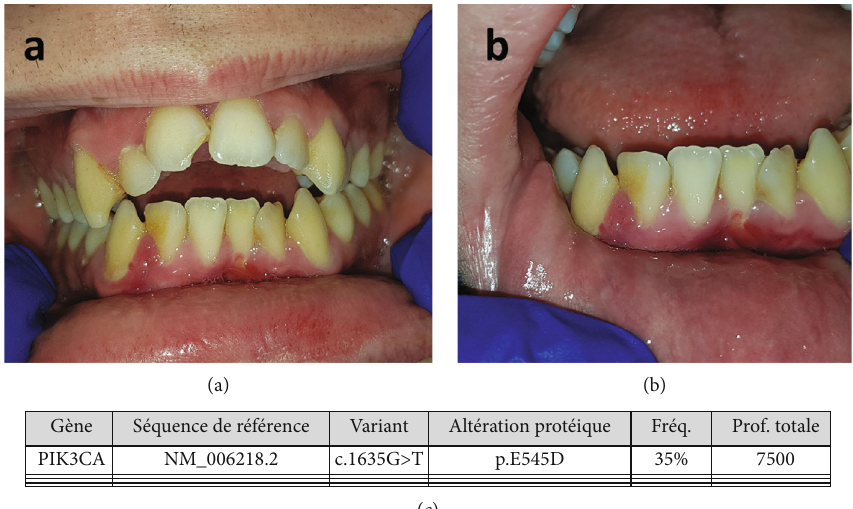
Figure 3: (a) Intraoral situation for patient 2. (b) Aspect of the in fl ammatory papillae between teeth 42 and 43. (c) Result of the genetic